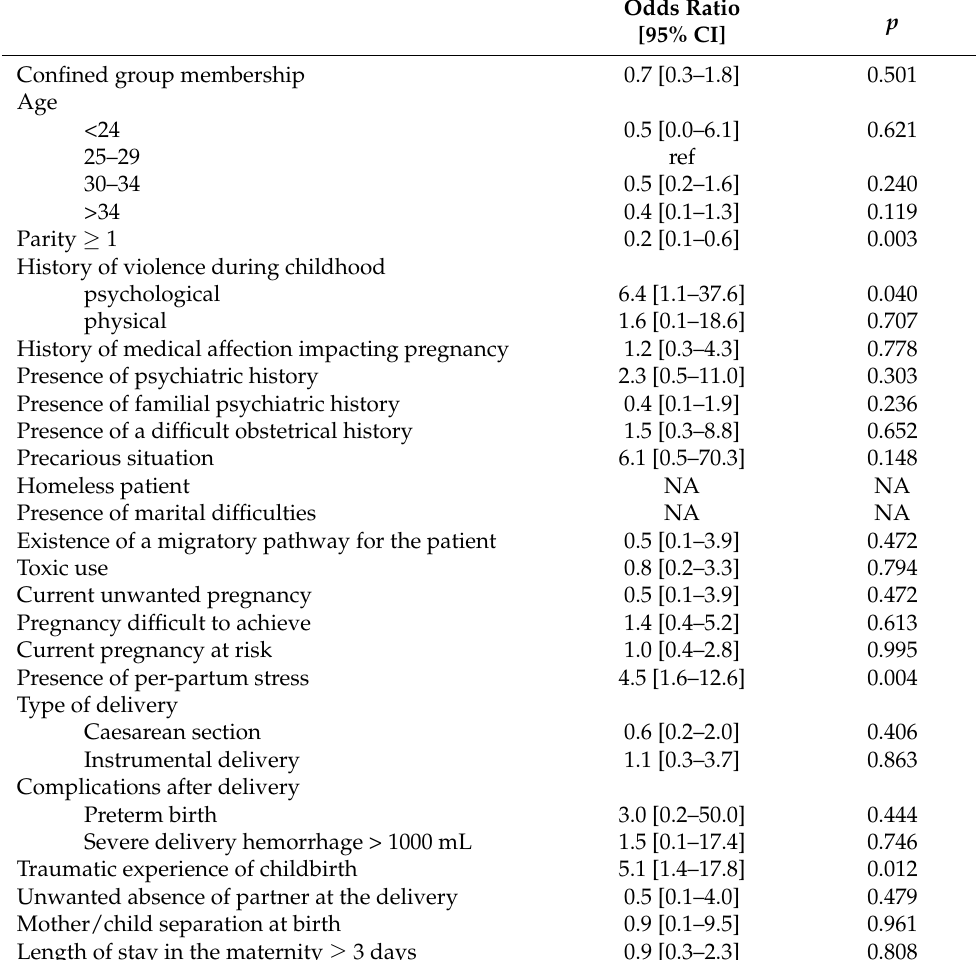
Table 4. Univariate analysis of risk factors for postpartum depression across all